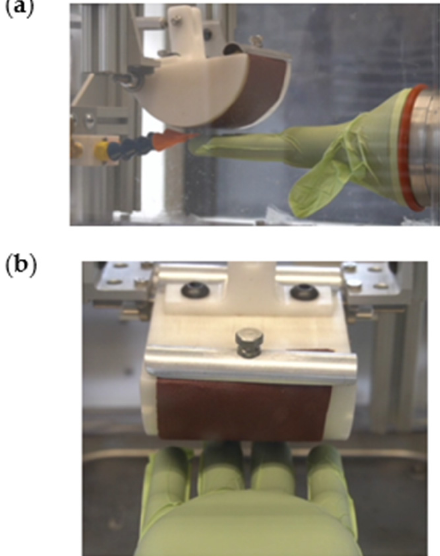
Figure 10. ( a ) Side view of drum with sandpaper and clamps, and ( b ) top view of drum with sandpaper and clamps.